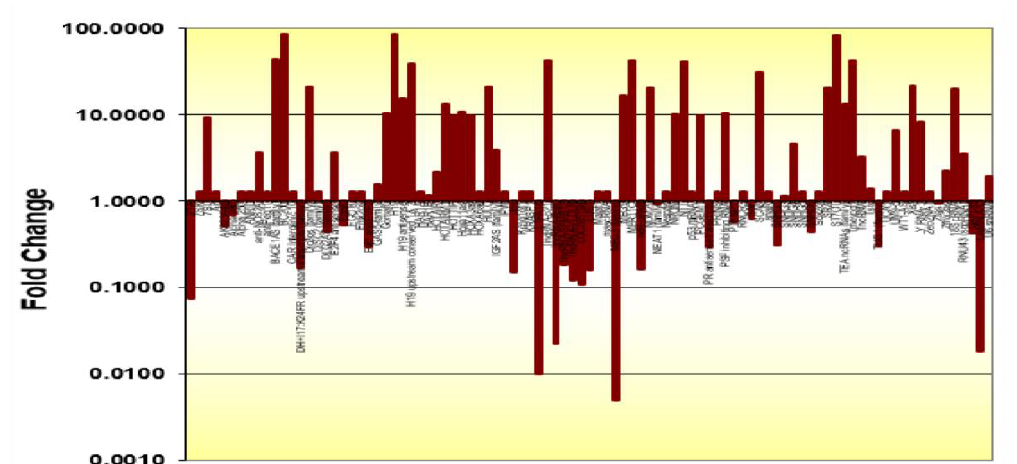
Figure 1: LncRNAs expression levels obtained by the human LncRNA Profiler qPCR Array Kit of which 42 were up-regulated but 23 were down-regulated in comparison with the healthy controls. Each bar represents an